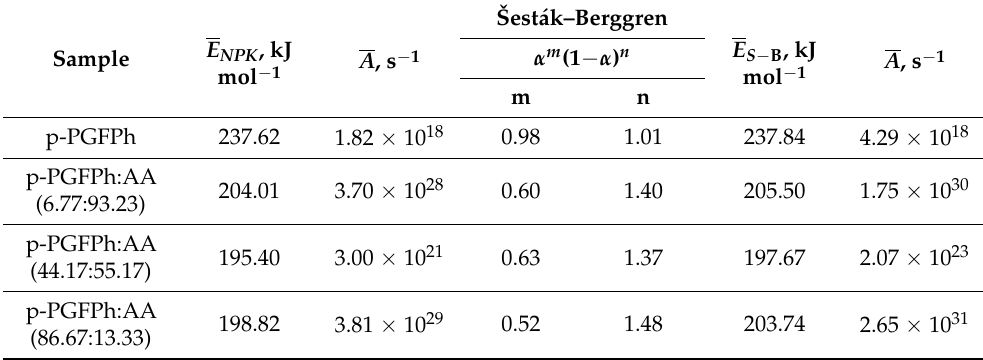
Table 3. p-PGFPh:AA copolymers thermal decomposition kinetic parameters at different ratios calculated by NPK method.